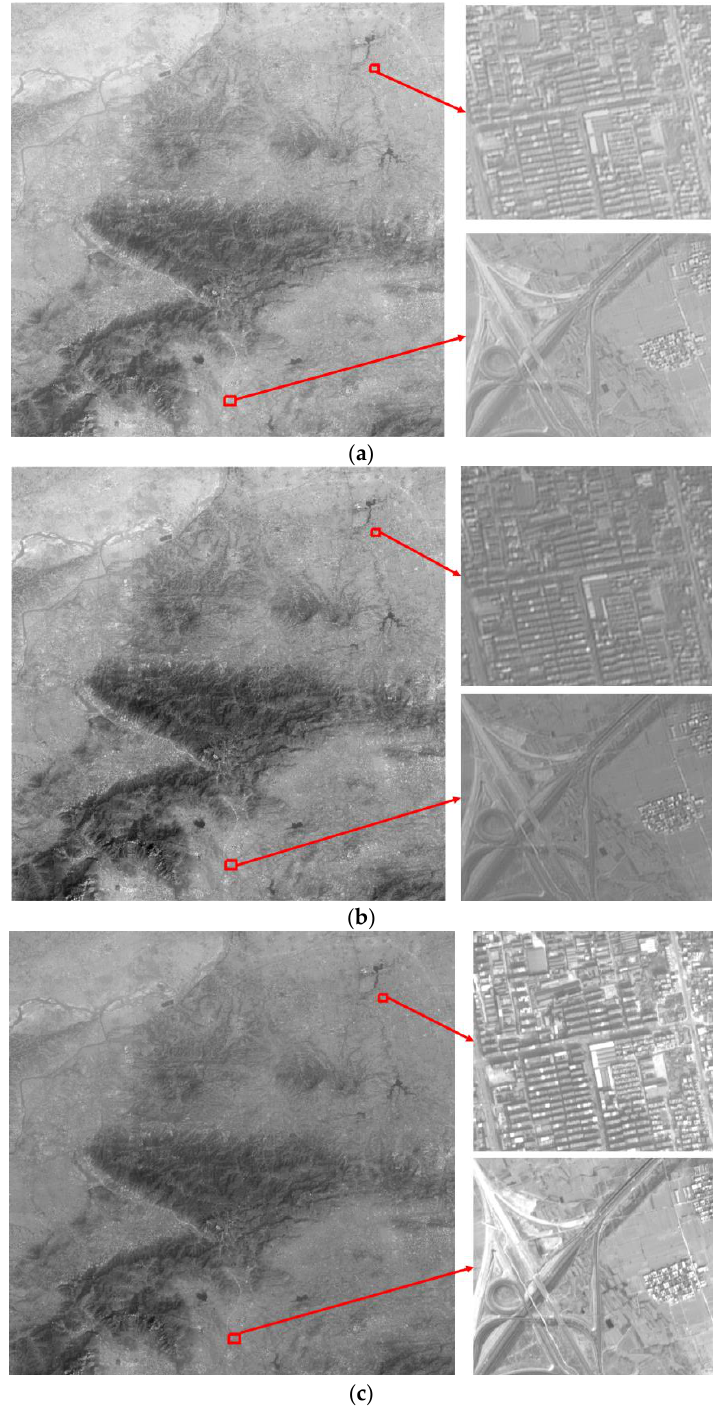
Figure 15. Comparison of the original image and the final result: ( a ) original forward image and its local amplification ( b ) original backward image and its local amplification ( c ) the final result and its local amplification.